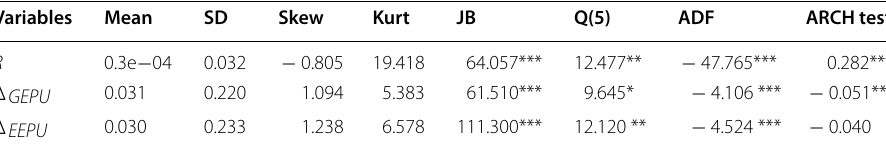
Table 1 Descriptive statistics of transformed data